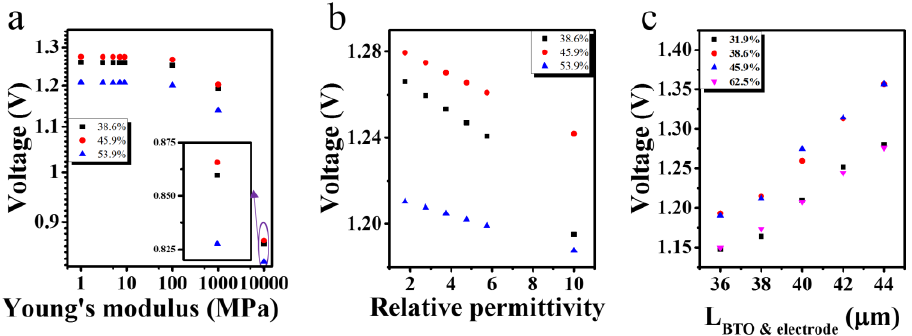
Figure 4. The open circuit voltage of the PENG at different polymer Young’s modulus ( a ), permittivity ( b ), and the distance between electrode and BaTiO 3 cubes ( c ).